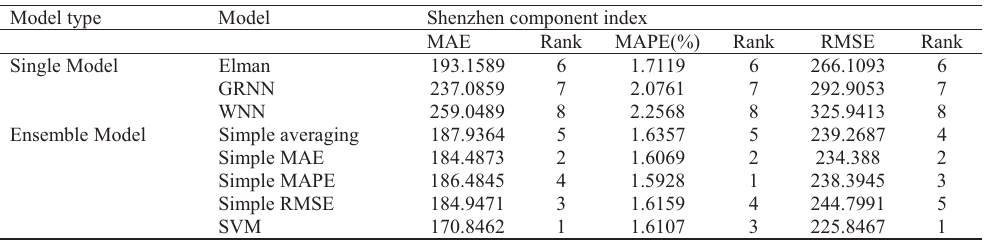
Table 3. Comparison of performance statistics averaging each model over 20 runs in Shenzhen component